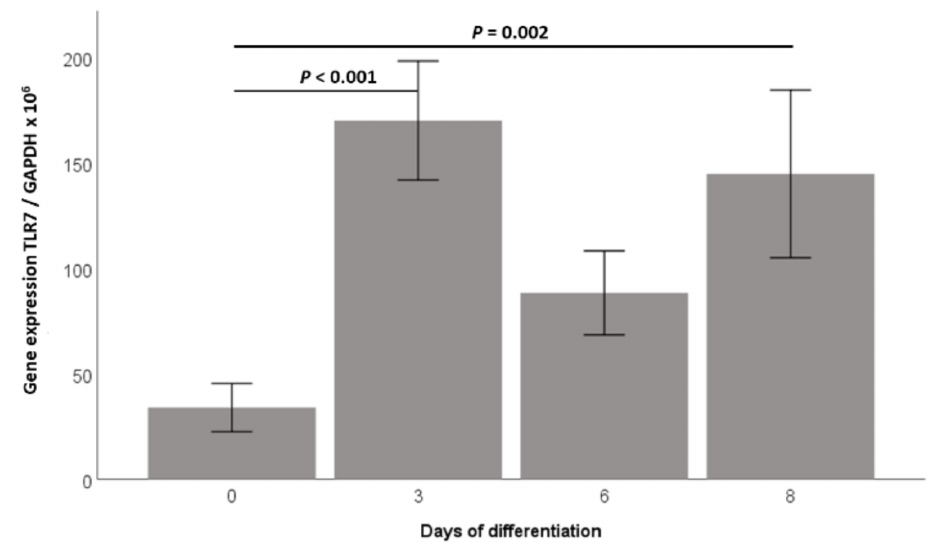
Figure 1. TLR7 gene expression is induced during 3T3-L1 adipocyte differentiation. TLR7 expression was investigated in 3T3-L1 fibroblasts (day 0) and pre-adipocytes (days 3 and 6) during differentiation into mature adipocytes (day 8). TLR7 mRNA levels (analyzed by RT-PCR) exhibited an early and significant increase and remained elevated throughout the adipocytic differentiation process ( n = 11